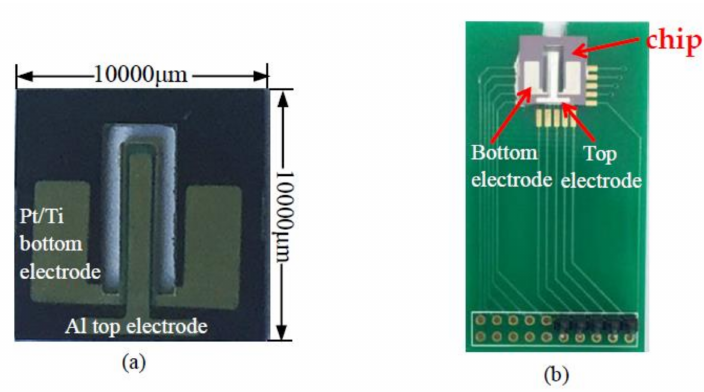
Figure 4. The chip photos of acceleration sensor: ( a ) photo of chip; ( b ) photo of packaging